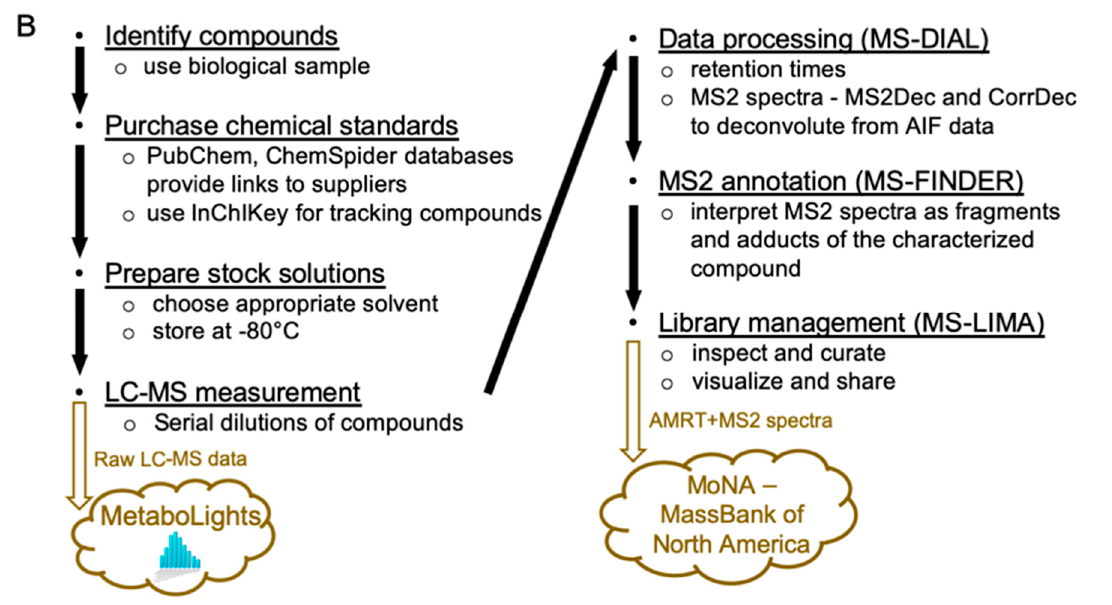
Figure 1. ( A ) Comparison of AIF (all ion fragmentation) and DDA (data dependent acquisition) MS2 spectra acquisition, ( B ) MS2 library construction workflow used in the current study.